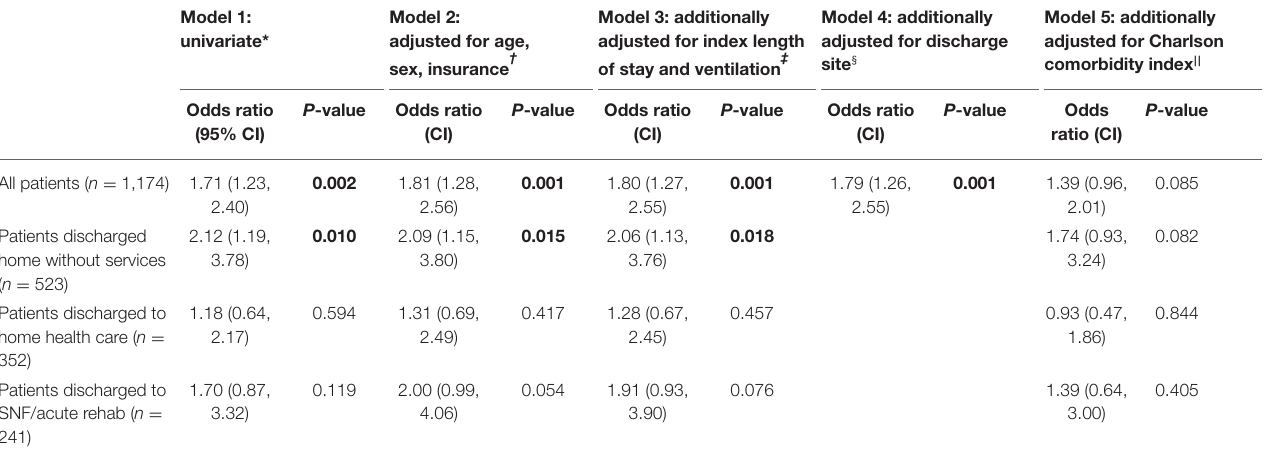
§ Model 4: Black race , sex, patient age, insurance , index admission length of stay (days), index admission mechanical ventilation, post-acute care on discharge. || Model 5: Black race, sex, patient age, insurance , index admission length of stay (days), index admission mechanical ventilation, post-acute care on discharge, Charlson Comorbidity Index